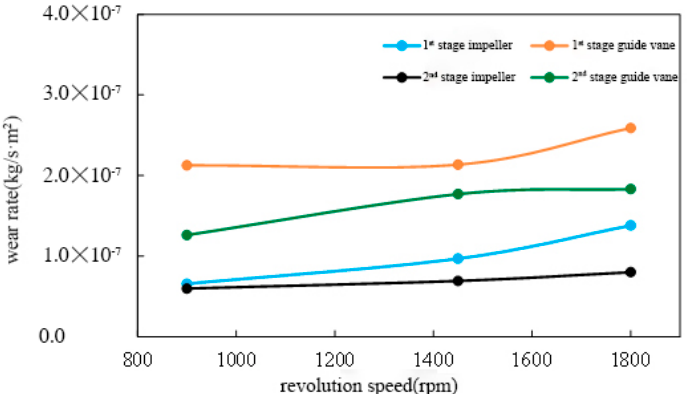
Figure 22. Changes in the wear rate on the surface of the through-passage components.